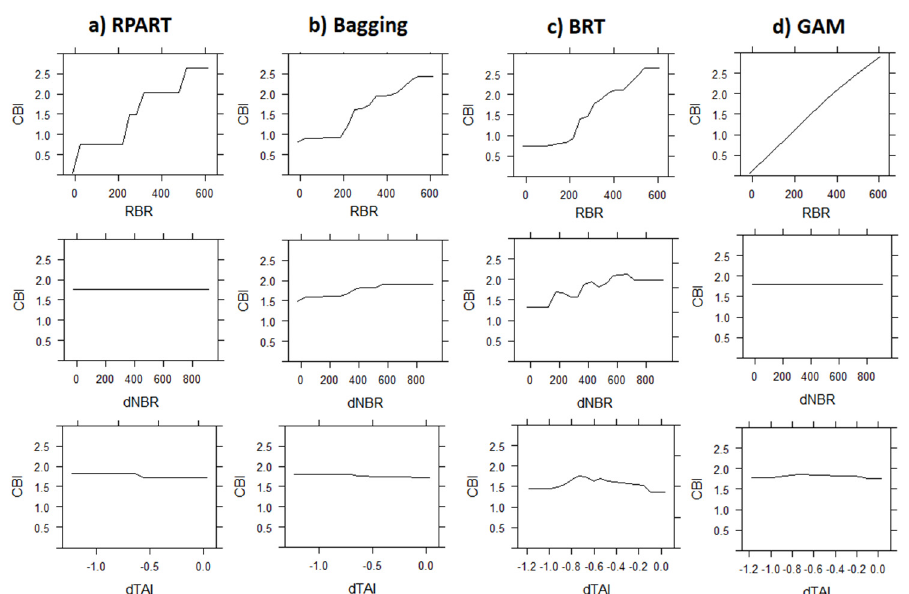
Figure 5. Partial dependence of CBI on the spectral severity indices used as explanatory variables from: ( a ) the regression tree (RPART); ( b ) the bagging; ( c ) the boosted regression tree (BRT); and ( d ) generalized additive (GAM) models using training data (n = 135). Here, it is shown only the significant spectral severity indices (RBR, dNBR, and dTAI).